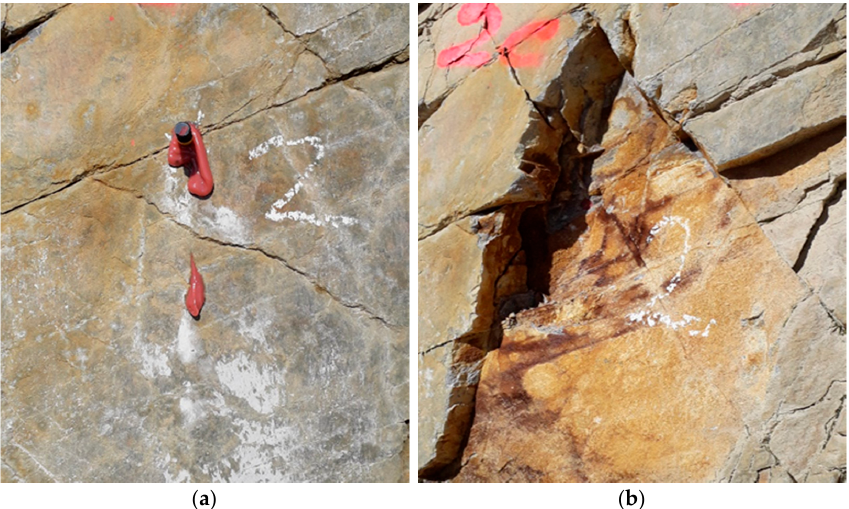
Figure 5. Joint weathering for ( a ) an installed anchor–weathering of joint unclear and ( b ) an anchor after failure–weathering of joint visible after failure occurred.